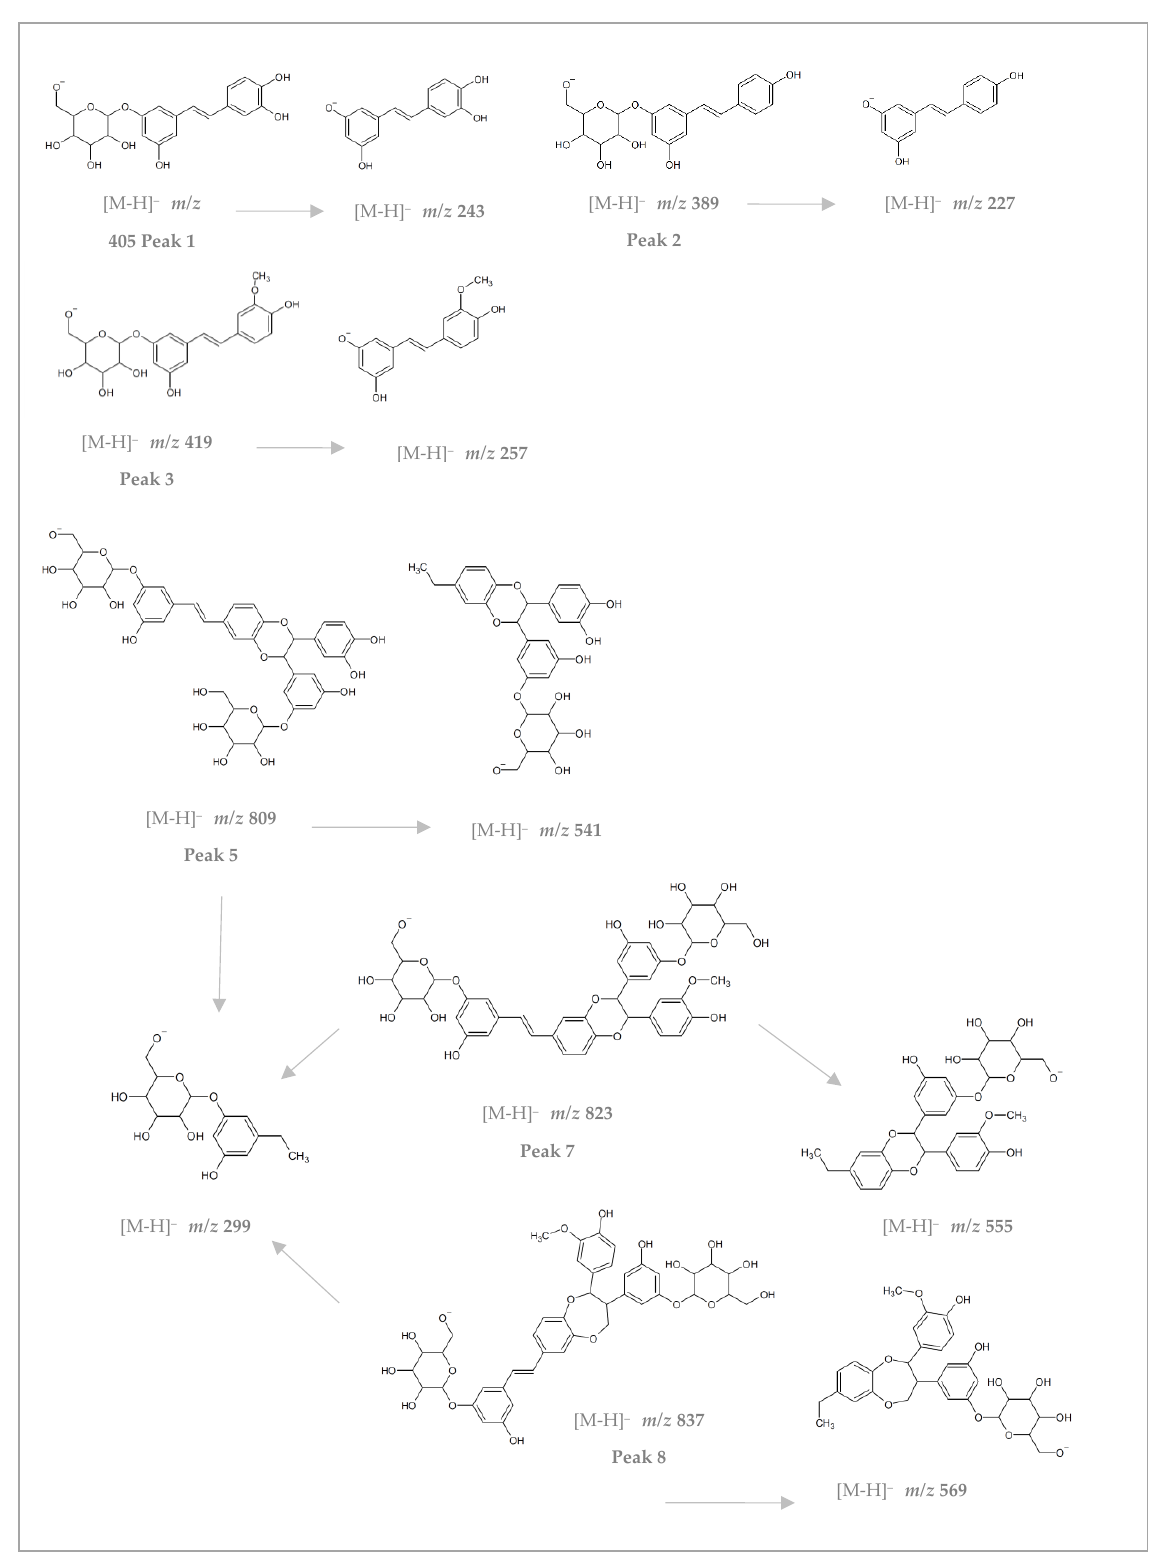
Figure A6. Suggested structures and fractionation of some detected compounds from the high-performance liquid chro- matography (HPLC) analysis of bark hot-water